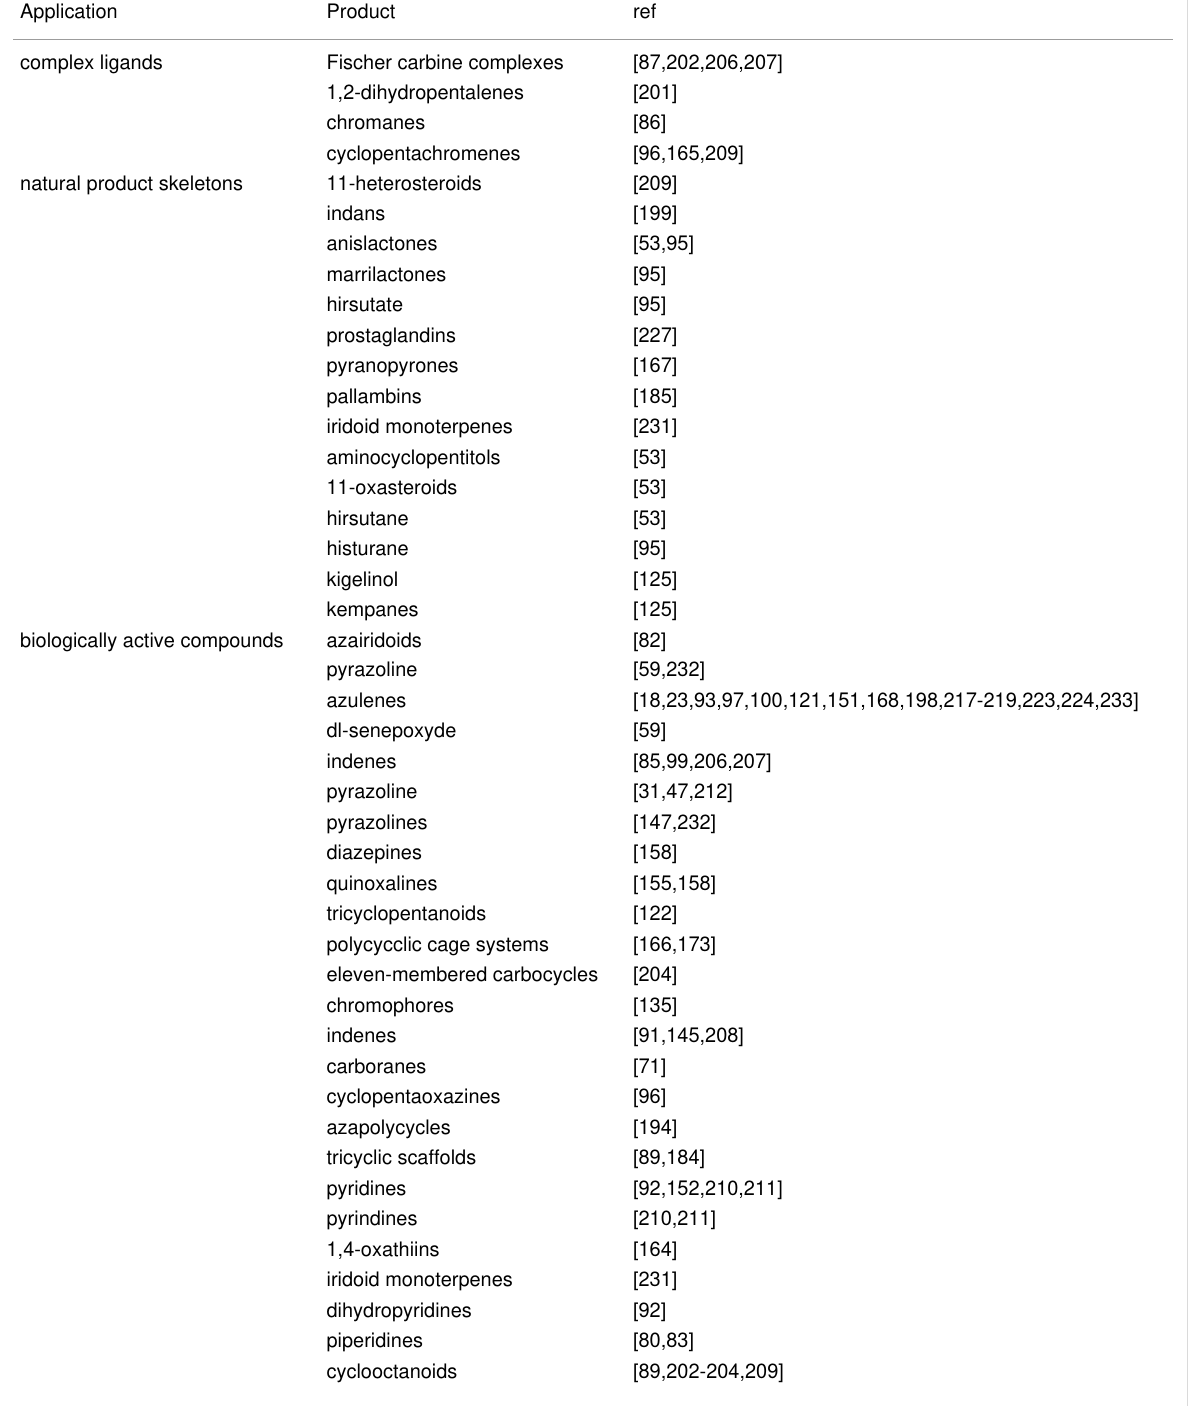
Table 3: Cyclic scaffolds prepared from fulvenes, grouped according to their